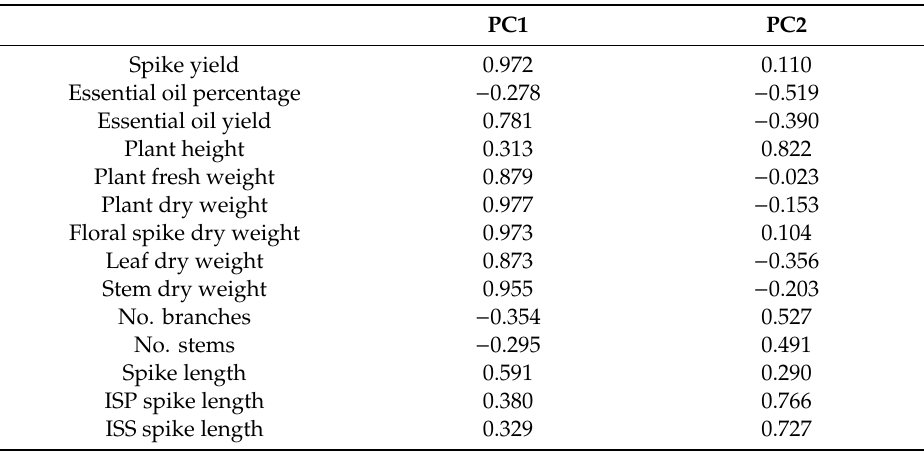
Table 10. Factor weights of properties on the two